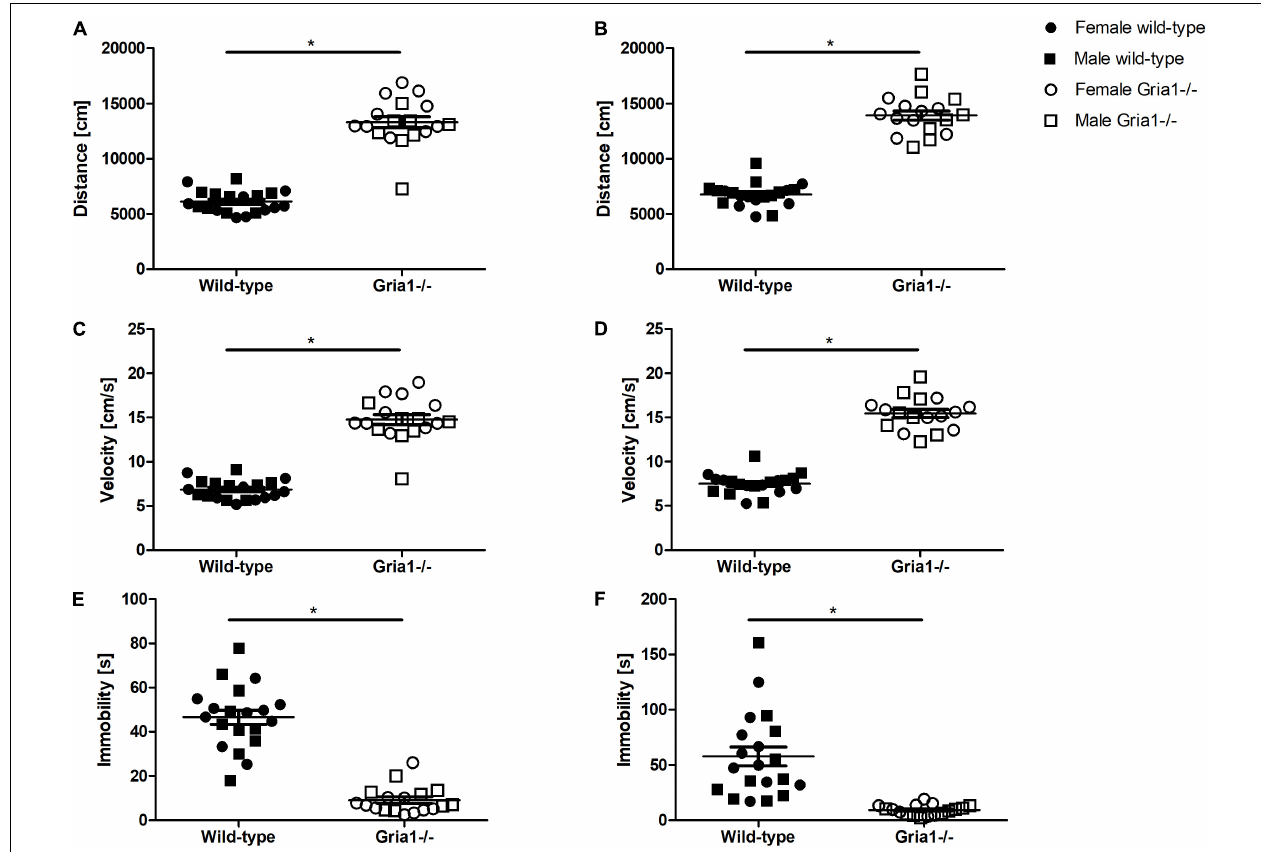
FIGURE 7 | Open field test – total monitoring duration. During the total observation period of 15 min, Gria1 − / − mice moved a greater distance than wild-type littermates during prepubescence (A) as well as once sexually mature (B) . Considering velocity of movement, Gria1 − / − mice moved with increased speed as compared to age-matched wild-types during prepubescence (C) and once sexually mature (D) . Considering states of immobility displayed by the mice, there were significant effects of genotype demonstrating that Gria1 − / − mice showed a shorter immobility duration than wild-type littermates during prepubescence (E) and once sexually mature (F) . ANOVA, followed by FDR-correction. n = 8–10 per genotype per sex. * p < 0.05. Error bars indicate the standard error of the mean (SEM).